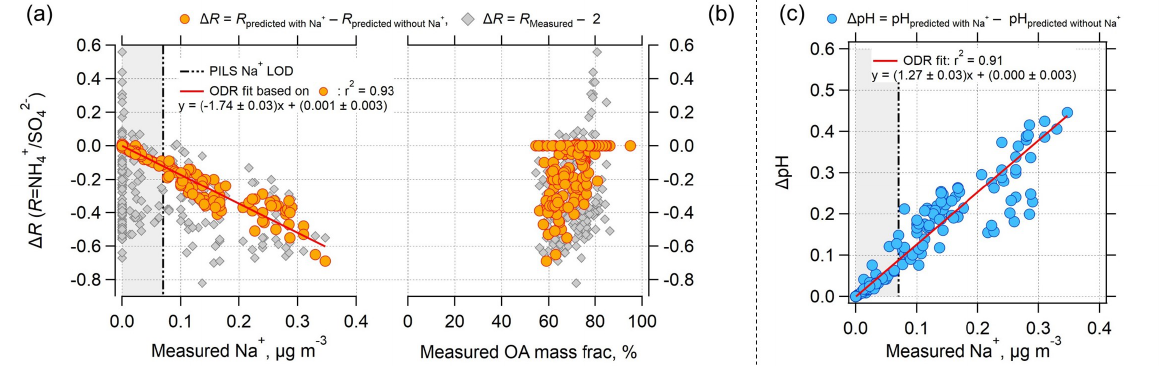
Figure 4. Effect of nonvolatile cations (NVC) on the PM 2 . 5 ammonium-sulfate molar ratios ( R ) and pH as a function of measured Na + concentration and organic aerosol (OA) mass fractions for the SOAS dataset studied. Plot (a) is (cid:49)R versus measured Na + , (b) is (cid:49)R versus measured OA mass fraction (OA mass divided by total particle mass reported from AMS), and (c) is (cid:49) pH versus measured Na + . Grey diamonds in plots (a) and (b) are for (cid:49)R equal to the measured R minus 2. Orange circular points are for (cid:49)R equal to ISORROPIA- predicted R with measured Na + included in the model input minus ISORROPIA-predicted R without Na + in the model input. (cid:49) pH in plot (c) is determined in a similar way. (cid:49)R is negative since including Na + in the thermodynamic model results in an R lower than 2, whereas not including Na + results in an R close to 2 (see Fig. 3). ODR fits are shown and uncertainties in the fits are 1 standard deviation. A plot similar to (b) , but versus OA mass concentration can be found as Fig. S6. The vertical dotted line is the Na + LOD of 0.07µgm − 3 . Regions where Na + is below LOD are marked with grey